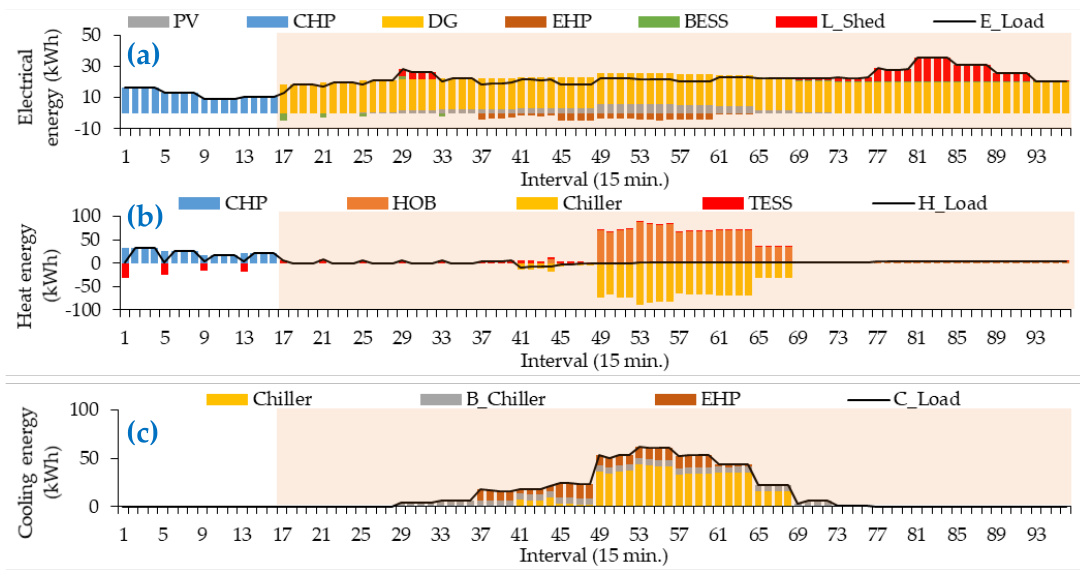
Figure 6. Energy balancing: ( a ) Electrical Energy; ( b ) Heat Energy; ( c ) Cooling Energy.